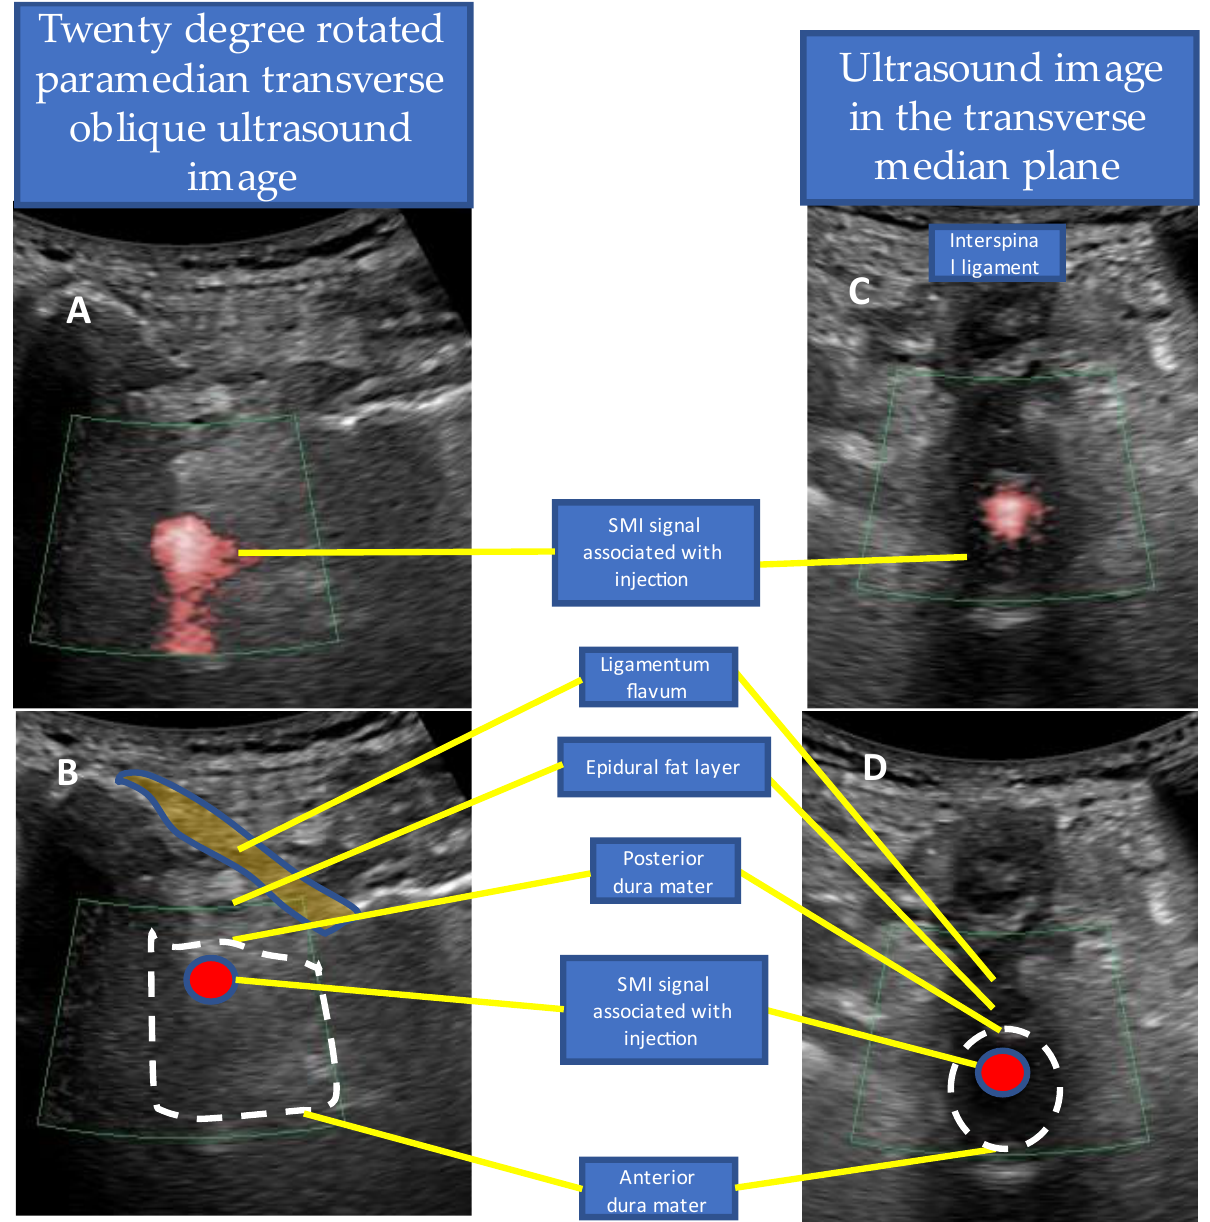
Figure 6. SMI signal associated with intrathecal injection. A 90-year-old male patient with lumbar spinal canal stenosis with intermittent claudication underwent US-guided lumbar epidural injection with loss of resistance from L5/S1. The SMI signal appeared in the thecal sac during the epidural injection. The injection was stopped immediately due to a suspected dural puncture, and the patient did not experience complications of spinal anesthesia. ( A ) Scan image of the L5–S1 intervertebral space showing the paramedian sagittal oblique orientation (rotated by 20 ◦ ). The SMI signal associated with the injection appeared in the thecal sac. ( B ) Schema of ( A ). ( C ) Transverse median plane scan image of the L5–S1 intervertebral space. The SMI signal detected in ( A ) was confirmed in the transverse median scan image in the thecal sac. ( D ) Schema of ( C ). Abbreviations: SMI, superb microvascular imaging.